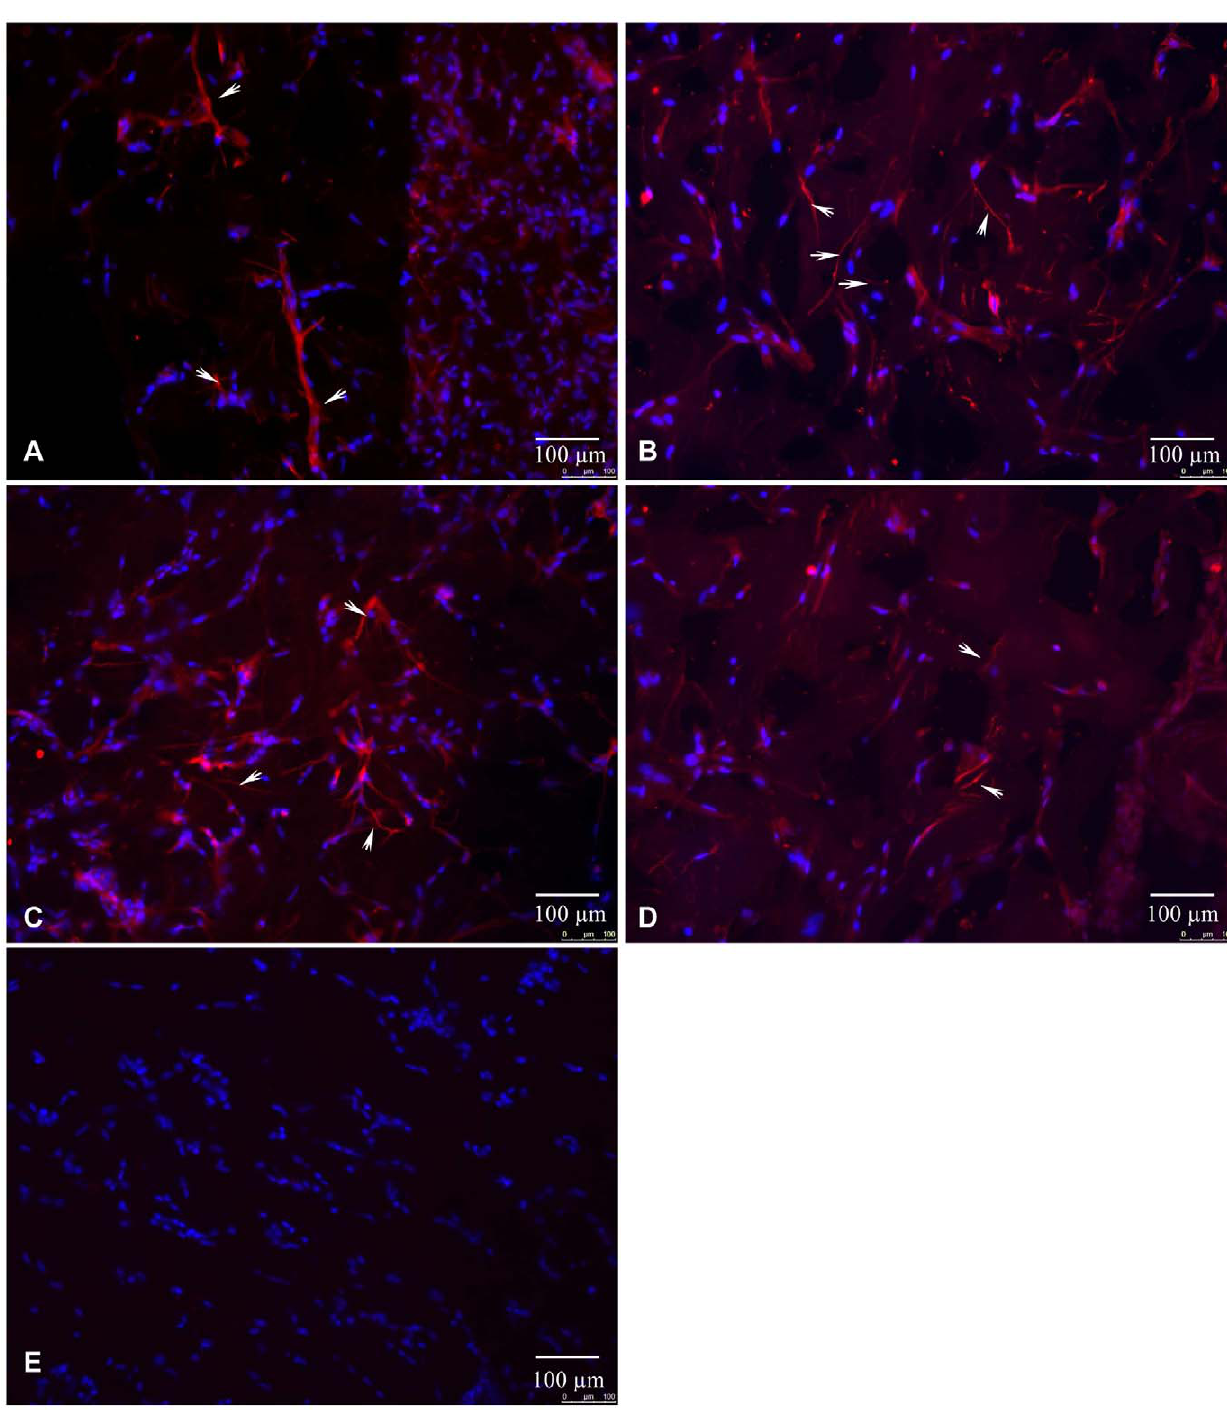
Figure 3. Expression of peripheral nerves markers in matrigel after mASCs transplantation. A–E. - Immunofluorescent staining of frozen matrigel sections with antibodies against neurofilament200 (A.), GAP43 (B.), tyrosine hydroxylase (C.), peripherin (D) or with non-specific IgGs (red fluorescence). Nerve fibers are indicated by arrows. Nuclei are counterstained with DAPI (blue fluorescence).